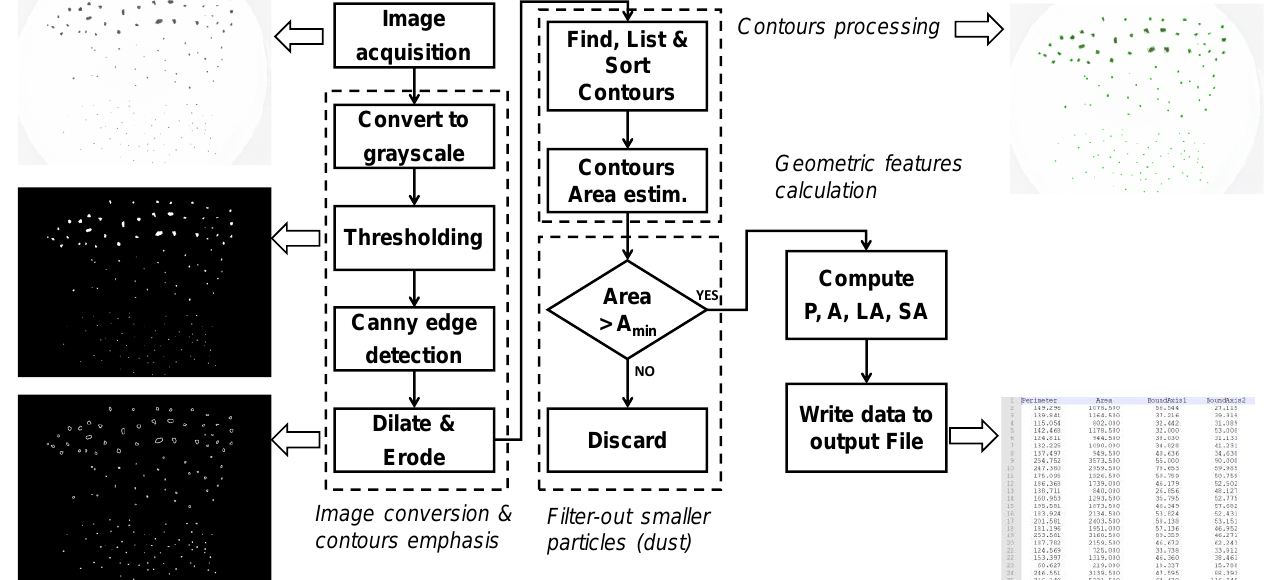
Figure 1. Flowchart of the image processing algorithm, together with some intermediate results generated by the system.